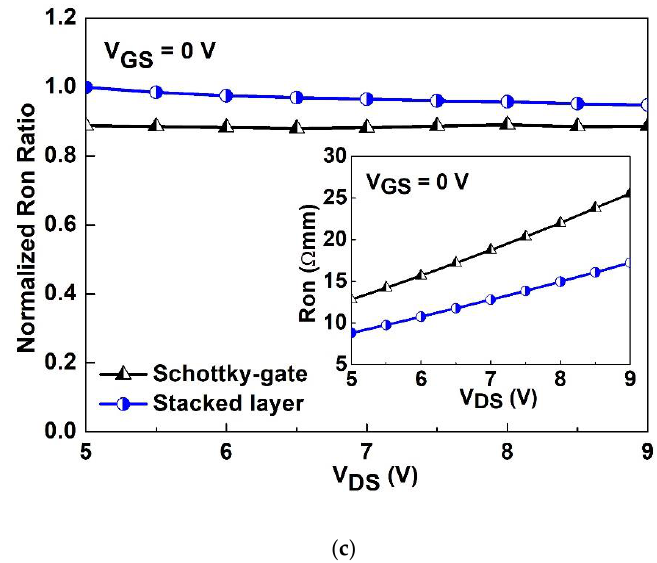
Figure 4. The pulse I DS -V DS characteristics of the ( a ) Schottky-gate HEMT and ( b ) the Al 2 O 3 /ZrO 2 MOS-HEMT. ( c ) The normalized dynamic R on and related static R on at V GS = 0 V for both devices. In order to have better insight into the impact of interface traps, high-frequency capacitance-voltage (C-V) and low-frequency noise (i.e., flicker noise) for both devices were measured, as shown in Figure 5a,b, respectively. When the up and down sweep lines do not coincide, the presence of hysteresis ( ∆ V) is mainly result from the interface traps. The interface trap density (D it ) was calculated via the capacitance and ∆ V from the high-frequency capacitance measurements [27]. The ∆ V (D it ) were 220 mV (1.92 × 10 12 cm − 2 eV − 1 ) for the Schottky-gate HEMT and 40 mV (2.44 × 10 11 cm − 2 eV − 1 ) for the stacked- layer MOS-HEMT. Lower flicker noise indicates fewer defects or traps at the interface between the metal gate and semiconductor. Defects or traps capture/emission charges via biases, and the total charges within the channel change, resulting in drain current degradation as shown in Figure 4. In addition, the frequency exponent ( γ ) was fitted as 1.63 and 1.04 for the reference HEMT and MOS-HEMT, respectively. A larger γ closely corresponded to generation-recombination center. Due to the stacked Al 2 O 3 /ZrO 2 layer, the electric field strength around the gate-drain region is relatively small, resulting in less carrier scattering in the channel. Thus, the Al 2 O 3 /ZrO 2 stacked layer reduces the gate leakage current at the interface and can also satisfy the dangling bonds on the GaN to suppress defects or traps, leading to reduced carrier scattering and flicker